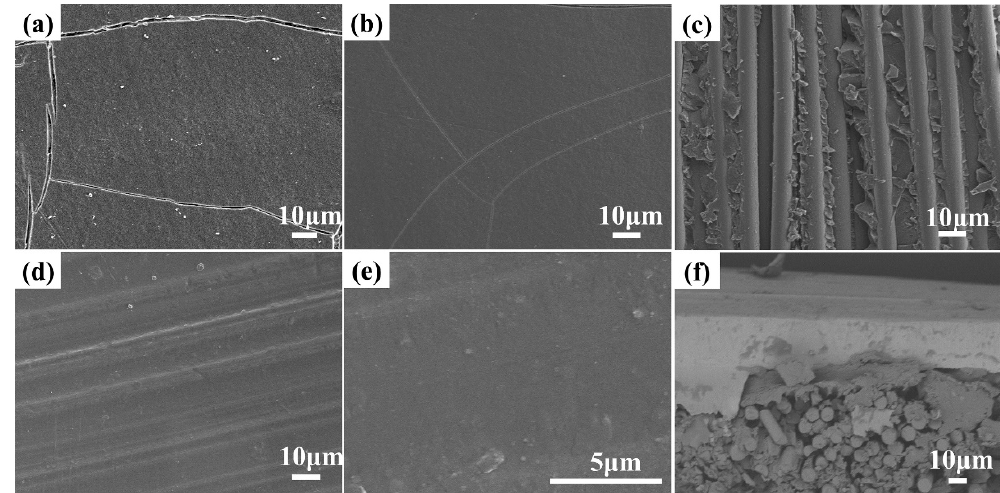
Figure 6. Surface SEM images of ( a , b ) insulation layers of P-CCLs; ( c ) filler and resin on the E-glass fabric; ( d , e ) insulation layers of LT-CCLs; ( f ) the cross sectional SEM images of LT-CCLs.